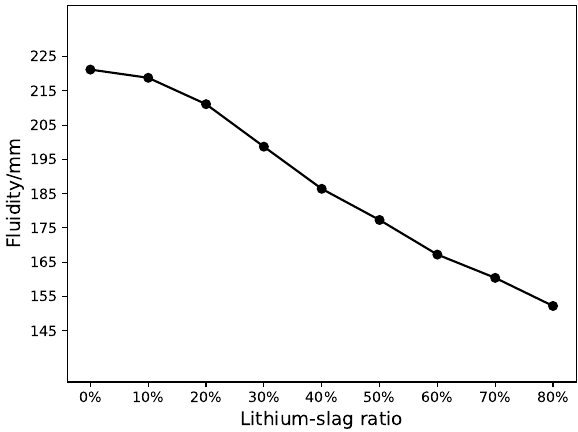
Figure 4. Fluidity of lithium-slag cement